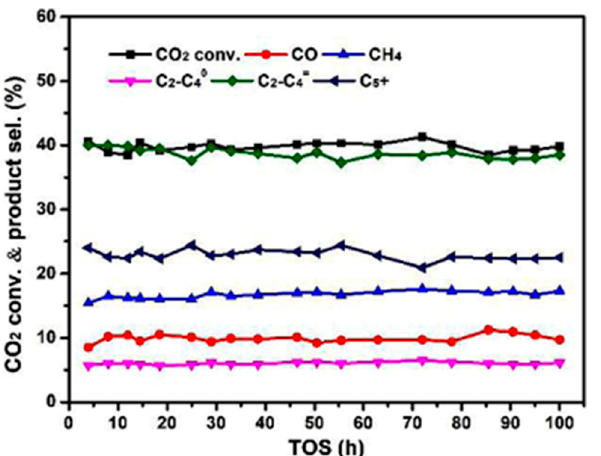
Figure 11. Catalytic performance of the CO 2 hydrogenation over the Na-CoFe 2 O 4 catalyst at TOS (reaction conditions: H 2 /CO 2 molar ratio = 3, T= 593 K, P = 3 MPa, GHSV = 7200 mL h − 1 gcat − 1 , TOS = 100 h). Adapted with permission from ref. [91]. Copyright 2021 Elsevier.